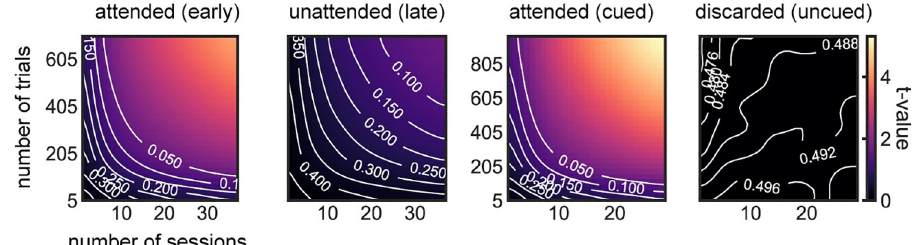
Fig 2. Average voltage decoding during 200 ms prior to the impulse as a function of trial and session numbers [37]. Attended items could be robustly decoded from voltage, but not discarded items. Decoding of unattended items suggested a possible underlying signal ( p = 0.06, t = 1.55, one-sided t test, upper-right corner in second panel). Subsampling of sessions and trials was done by randomly subsampling ( n = 5,000) without repetition from the full dataset (Methods). In white, contour lines for different p -value levels (one-sided t test). Data from Wolff and colleagues (2017) [7].